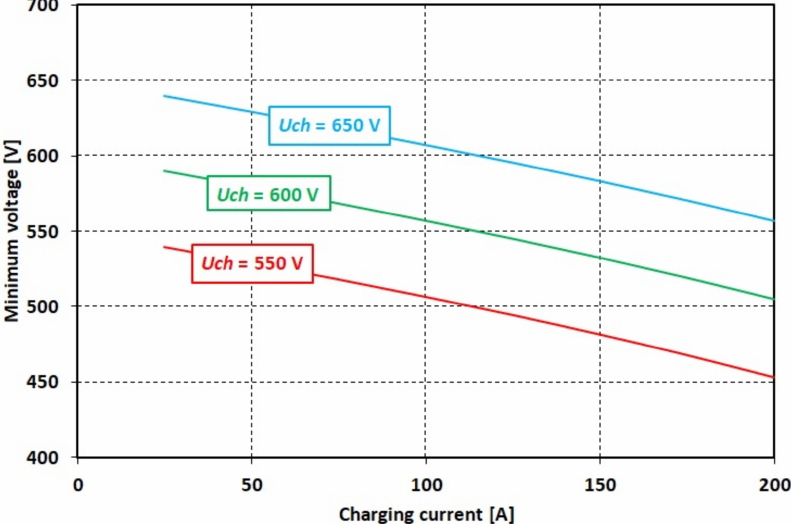
Figure 10. Calculation outcomes—minimum voltage in cathenary charging current for different voltage levels U ch of charging activation during BS